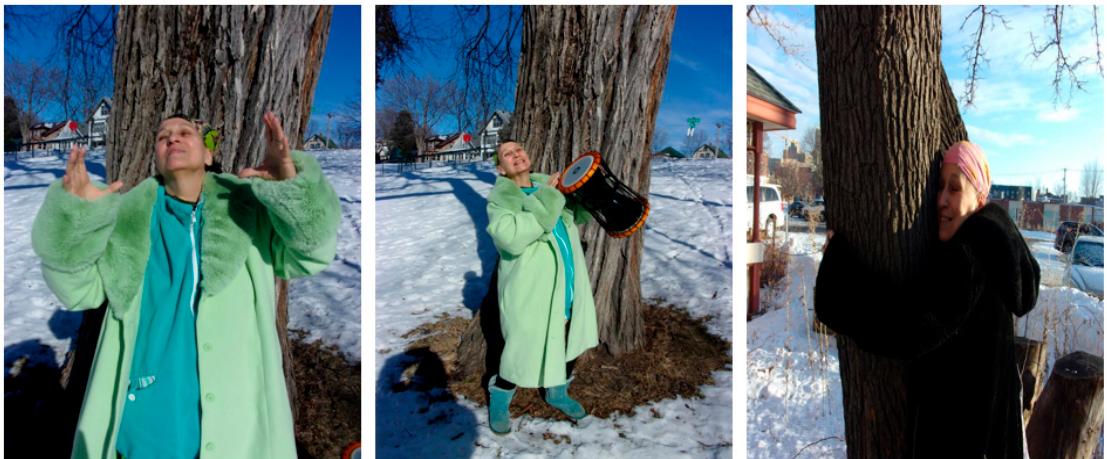
Figure 6. This trio of images show an older adult not only full of joy, but finding rejuvenation.